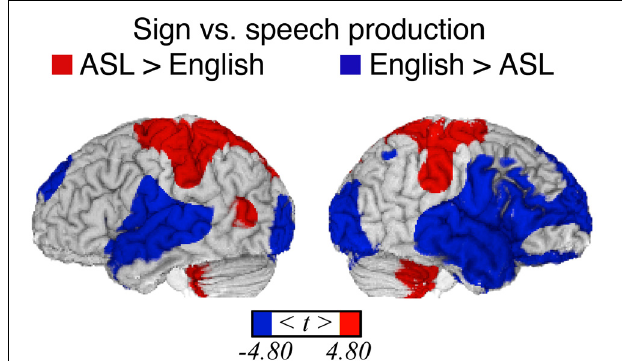
FIGURE 1 | Significant differences in language production-related activity depending on modality ( p < 0 . 05, corrected using RFT) overlaid onto an individual brain. Surface differences are observed in both primary sensory/motor areas and higher order association cortex. Regions more active for signing (indicated in red) include bilateral sensory-motor areas associated with control of the upper limbs, superior parietal lobule, left middle temporal gyrus (in the vicinity of area MT), and bilateral anterior/inferior cerebellum. Regions more active for speaking (blue) include bilateral sensory-motor areas associated with control of face/mouth, superior temporal, superior frontal, extrastriate visual cortices, and right middle frontal and inferior temporal